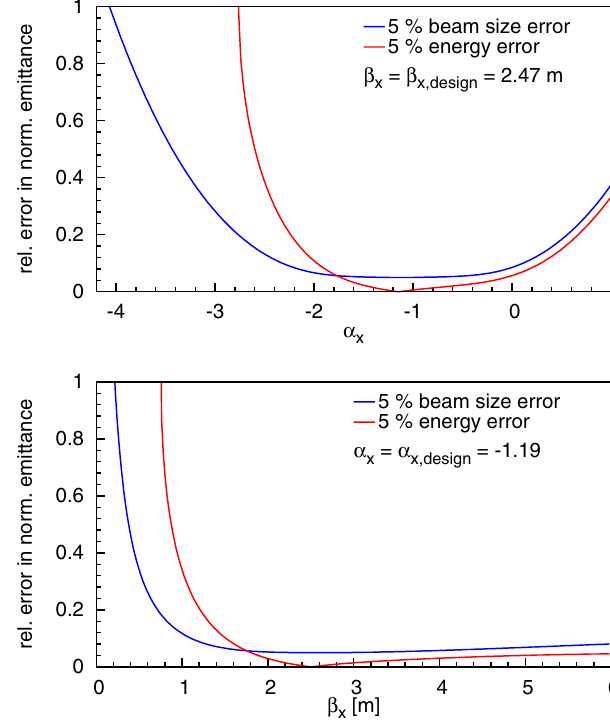
FIG. 4. (Color) Cut through the two-dimensional diagrams de- picted in Fig. 3 showing the dependence of the relative system- for atic error in the normalized emittance as a function of (cid:3) x (cid:4) (cid:3) (cid:4) (top) and as a function of (cid:4) for (cid:3) (cid:3) (cid:3) x; design x x; design (bottom).